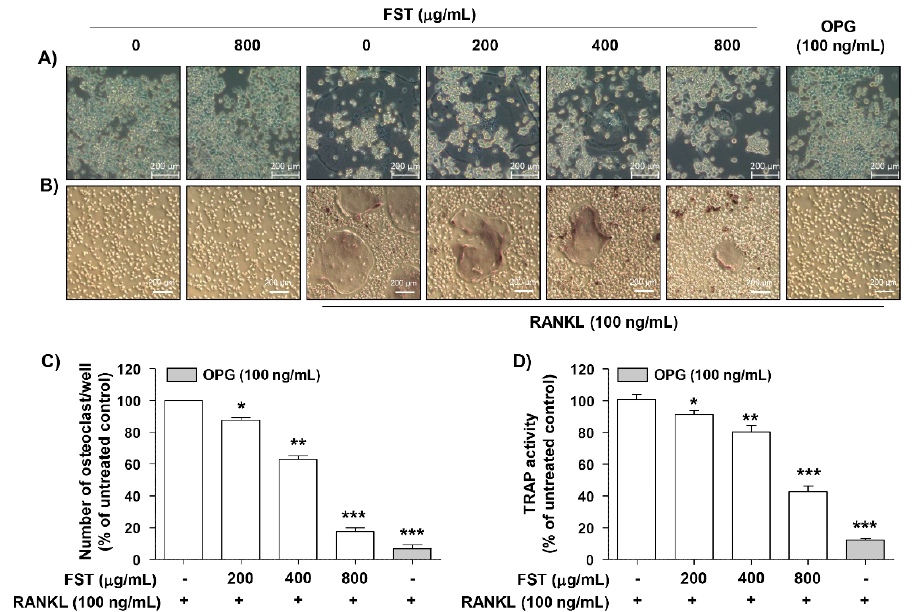
Figure 2. Inhibition of RANKL-stimulated osteoclast differentiation by FST in RAW 264.7 mouse macrophage-like cells. Cells were stimulated with 100 ng/mL RANKL in the presence or absence of FST or 100 ng/mL OPG for 5 days. ( A ) Representative photographs of the morphological changes are presented. ( B ) Cells were fixed and stained for TRAP and examined under an inverted microscope. ( C )TRAP-positivemultinucleatedcellswerecountedtodetermineosteoclastnumbers. ( D )Supernatants